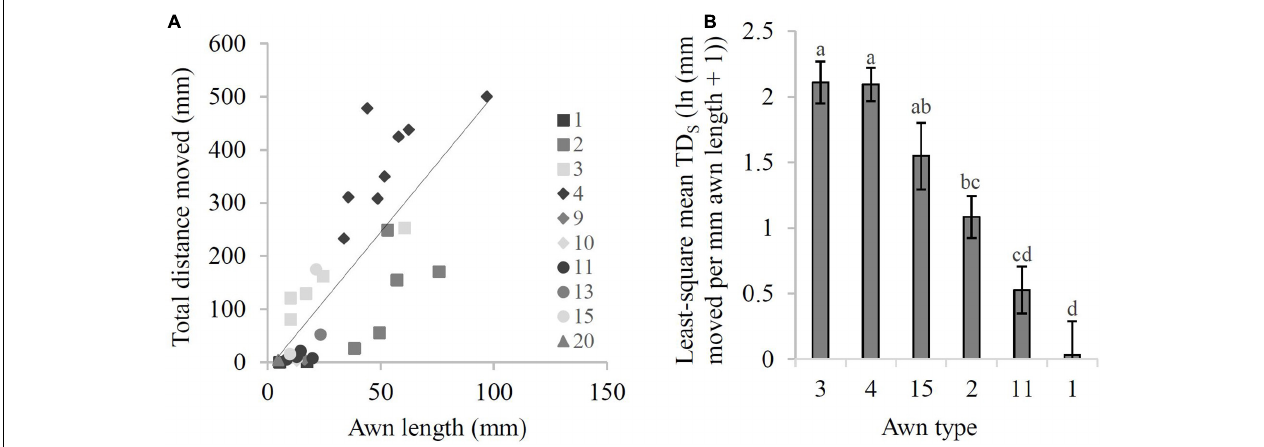
FIGURE 3 | Distance moved by awn types in the hardboard experiment. (A) Linear regression of awn length against total distance moved (TD A ) (in mm; after five wet-dry cycles) for all 30 species ( y = 5.17 x – 13.29, r = 0.76). Legend shows awn type. (B) Least-square mean values for total distance moved (after five wet-dry cycles) standardized by awn length (TD S ) [ln (mm moved per mm awn length + 1)]. Error bars represent one standard error. Means sharing the same letter do not differ at the 0.05